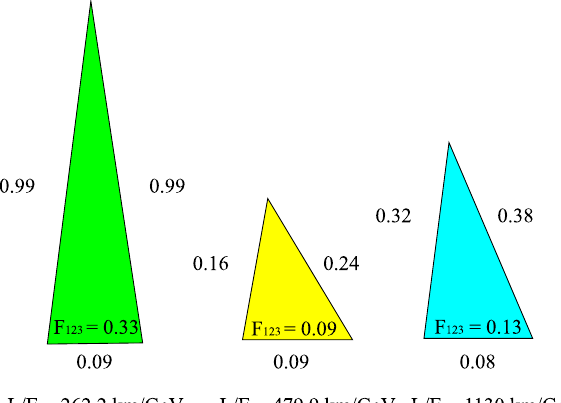
Fig. 6 The lengths of the edges and the areas for the concurrence tri- angles with L / E = 262 . 2 km / GeV, L / E = 479 . 9 km / GeV, and L / E = 1130 km / GeV, respectively, are shown in the three-flavored muon